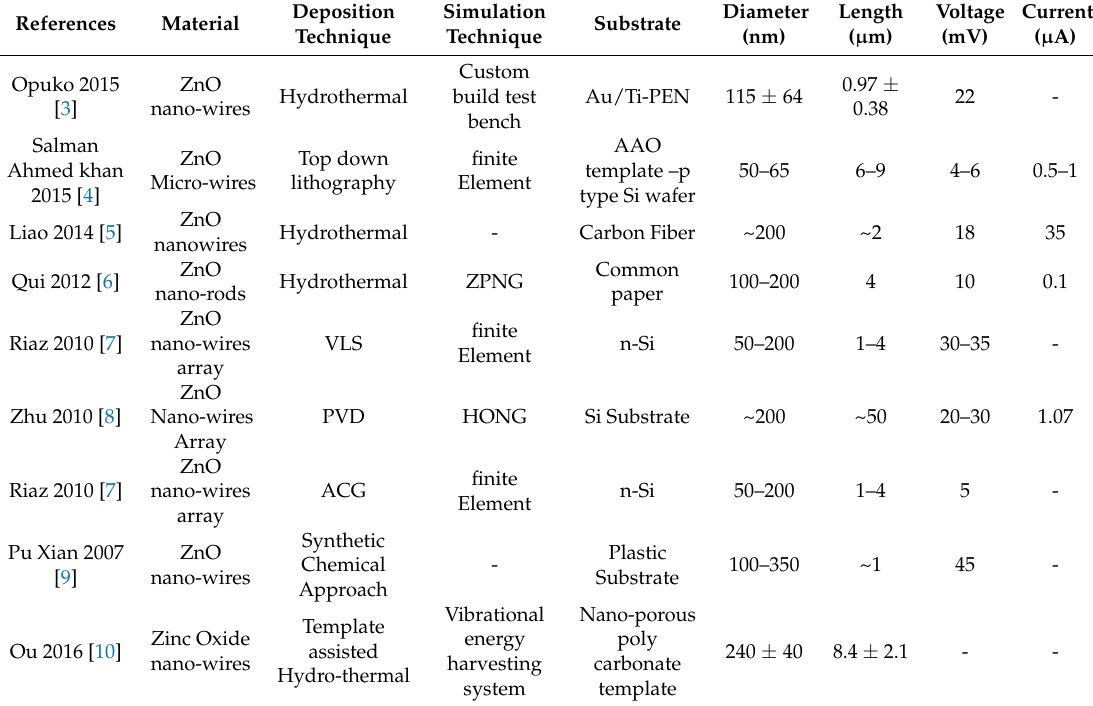
Table 1. Variations of voltage and current for a ZnO nano-structures-based energy harvester.